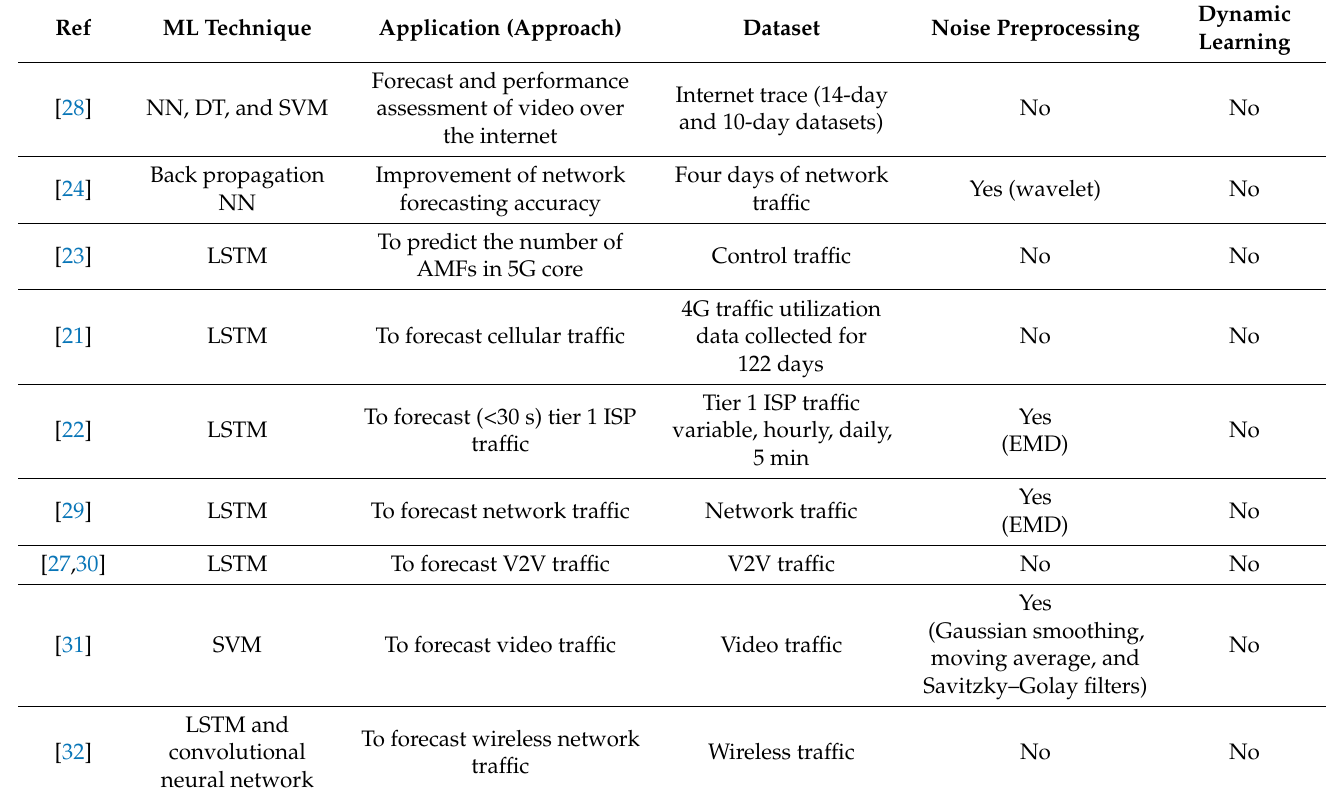
Table 1. Related work